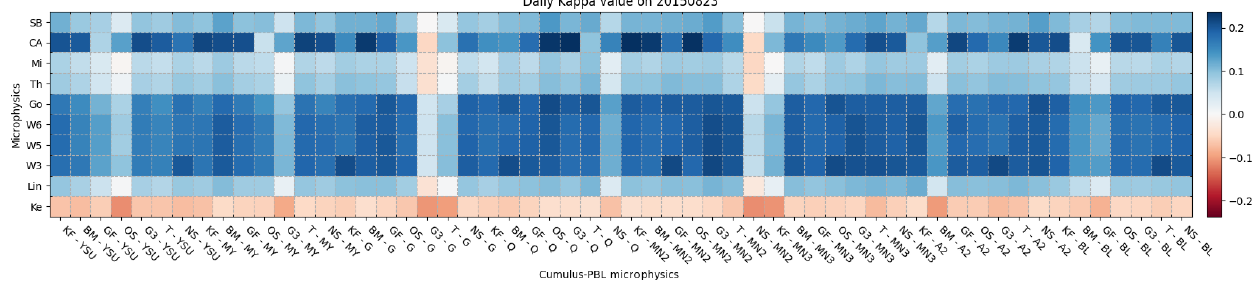
Figure 6. The heat map of the average κ for every configuration for the clusters of microphysics ( y axis) with the cluster of cumulus parameterization and PBL ( x axis) for the simulation case on 23 August for Set 1. The data only use the last 36h of simulations for calculating κ